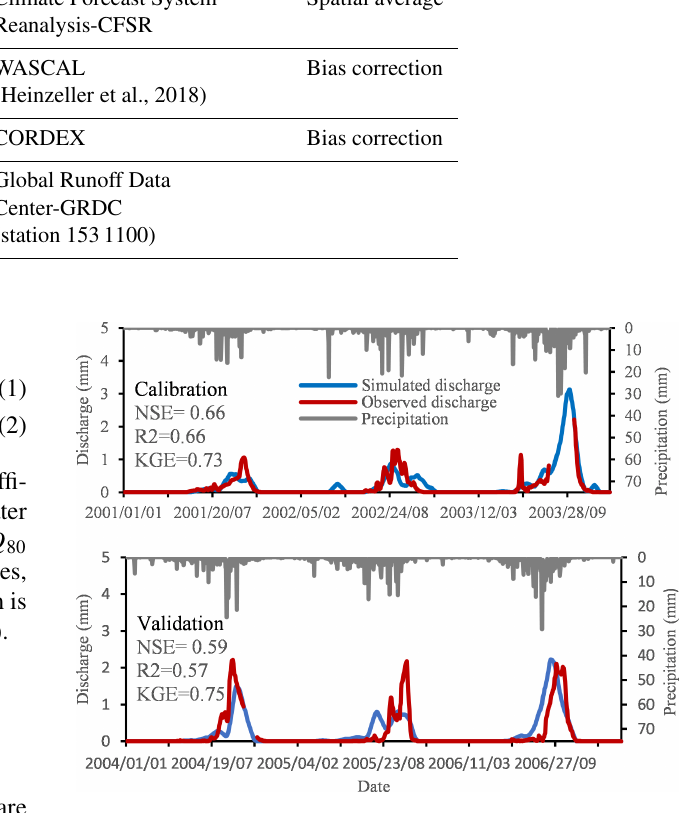
Figure 2. Calibration and validation results of the HBV for Bamboi catchment for the period 2001–2004 and 2004–2007